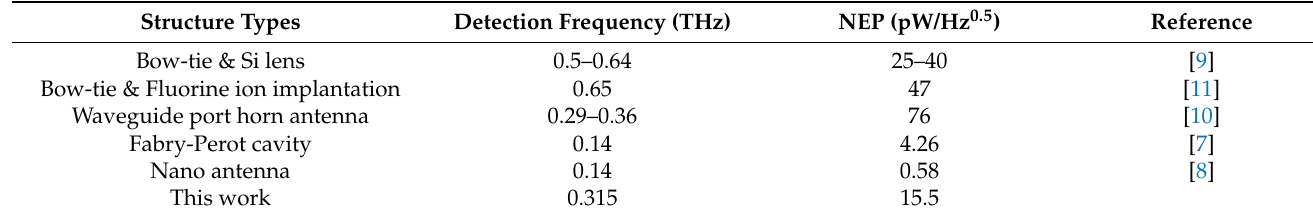
Table 2. Comparison of different types of GaN/AlGaN HEMT THz